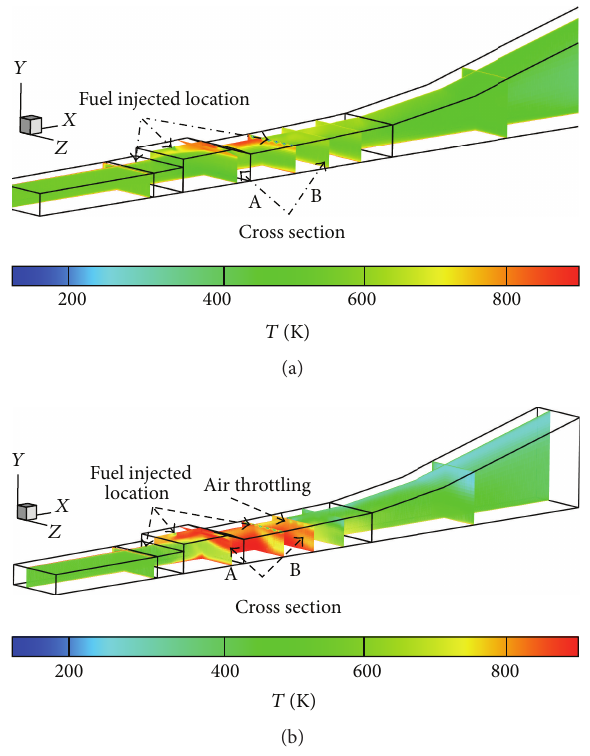
Figure 5: Static temperature contours of scramjet combustor with and without air throttling ((a) case without air throttling; (b) case with air